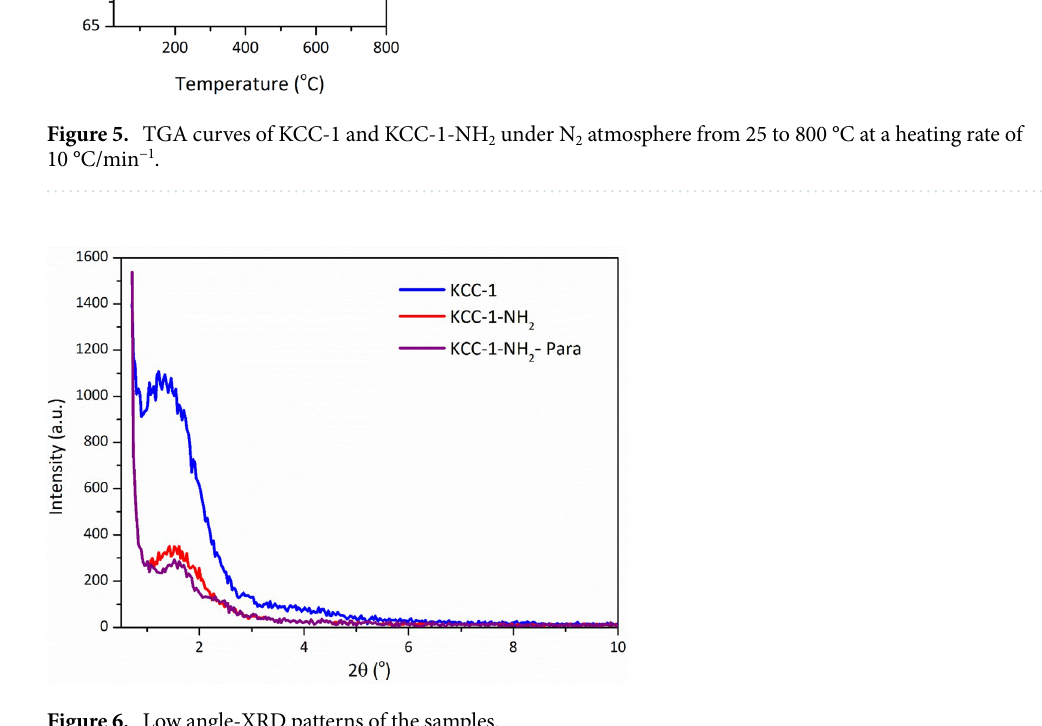
Figure 6. Low angle-XRD patterns of the